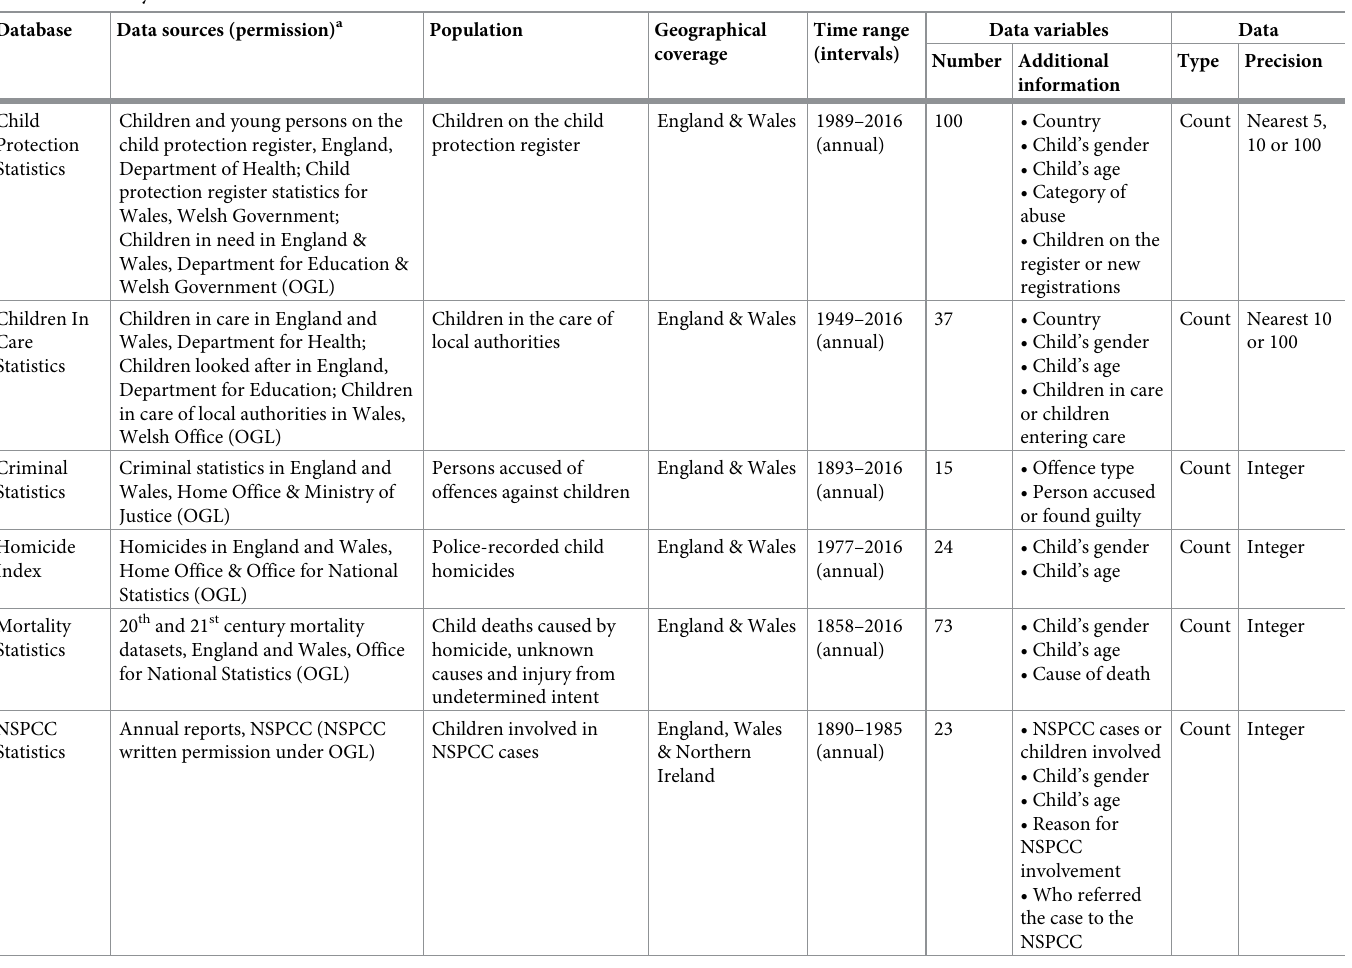
Table 1. Summary of database